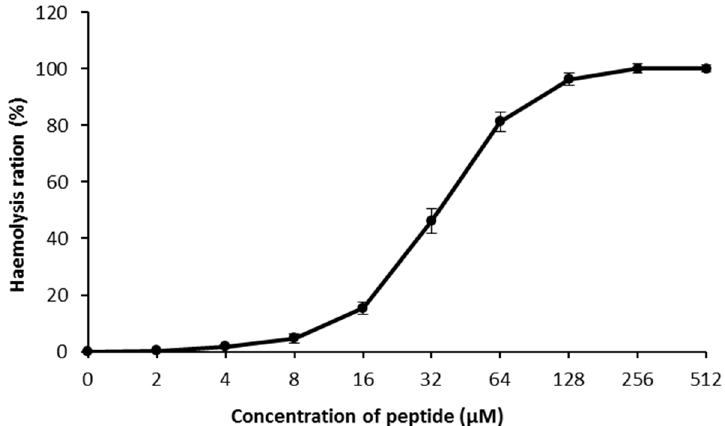
Figure 6. Hemolytic activity of LGH2. The experiment was performed in triplicate, for which the standard deviation is shown. The experimental values were normalized with the results for 1 × PBS (0% hemolysis) and 1% Triton X-100 (100% hemolysis).